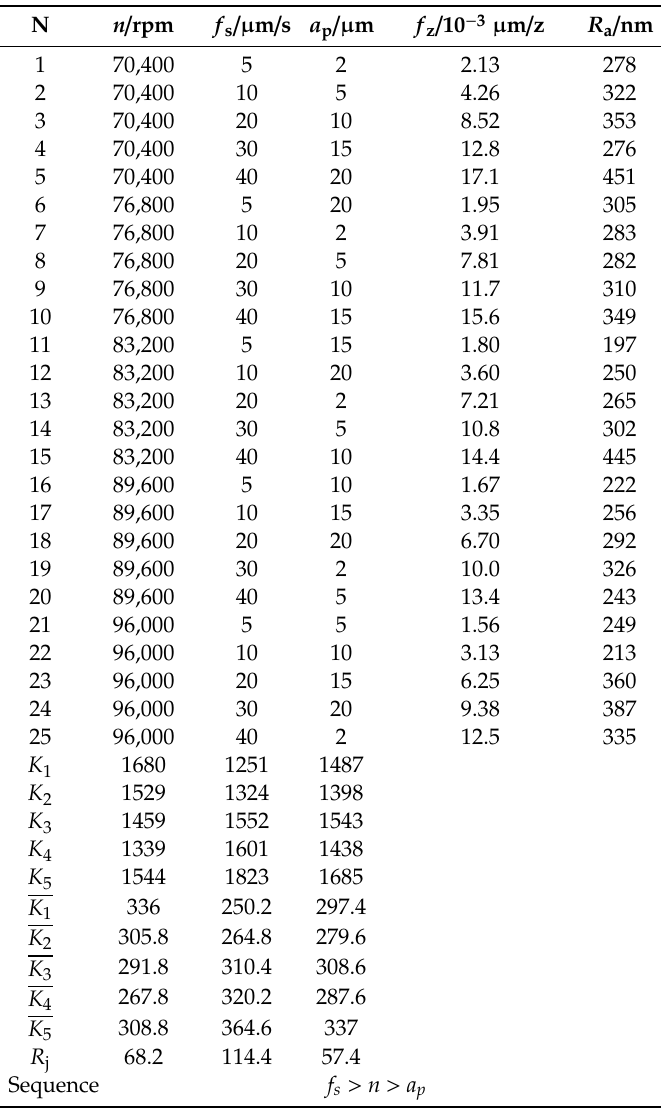
Figure 9. Groove bottom surface topography for Ti6Al4V. ( a ) Surface 3D topography. ( b ) Surface 2D topography. Table 4. Experimental measurements for Ti6Al4V.